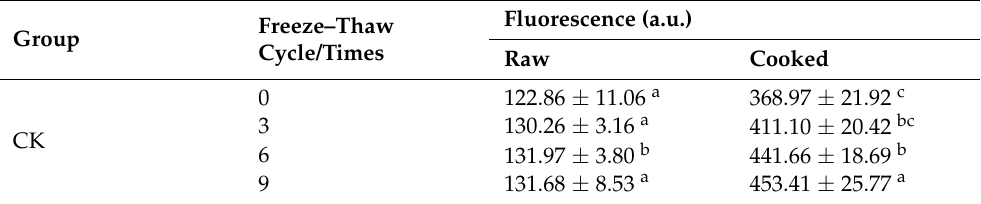
Table 2. Changes of Schiff bases contents in ground pork during freeze–thaw cycles and subsequent heating (100 ◦ C, 30